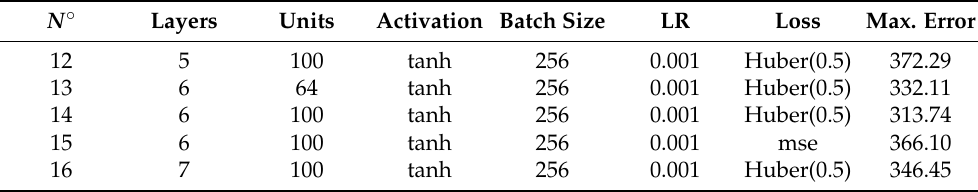
Table 8. Results of different models for arrival times without ReduceLROnPlateau